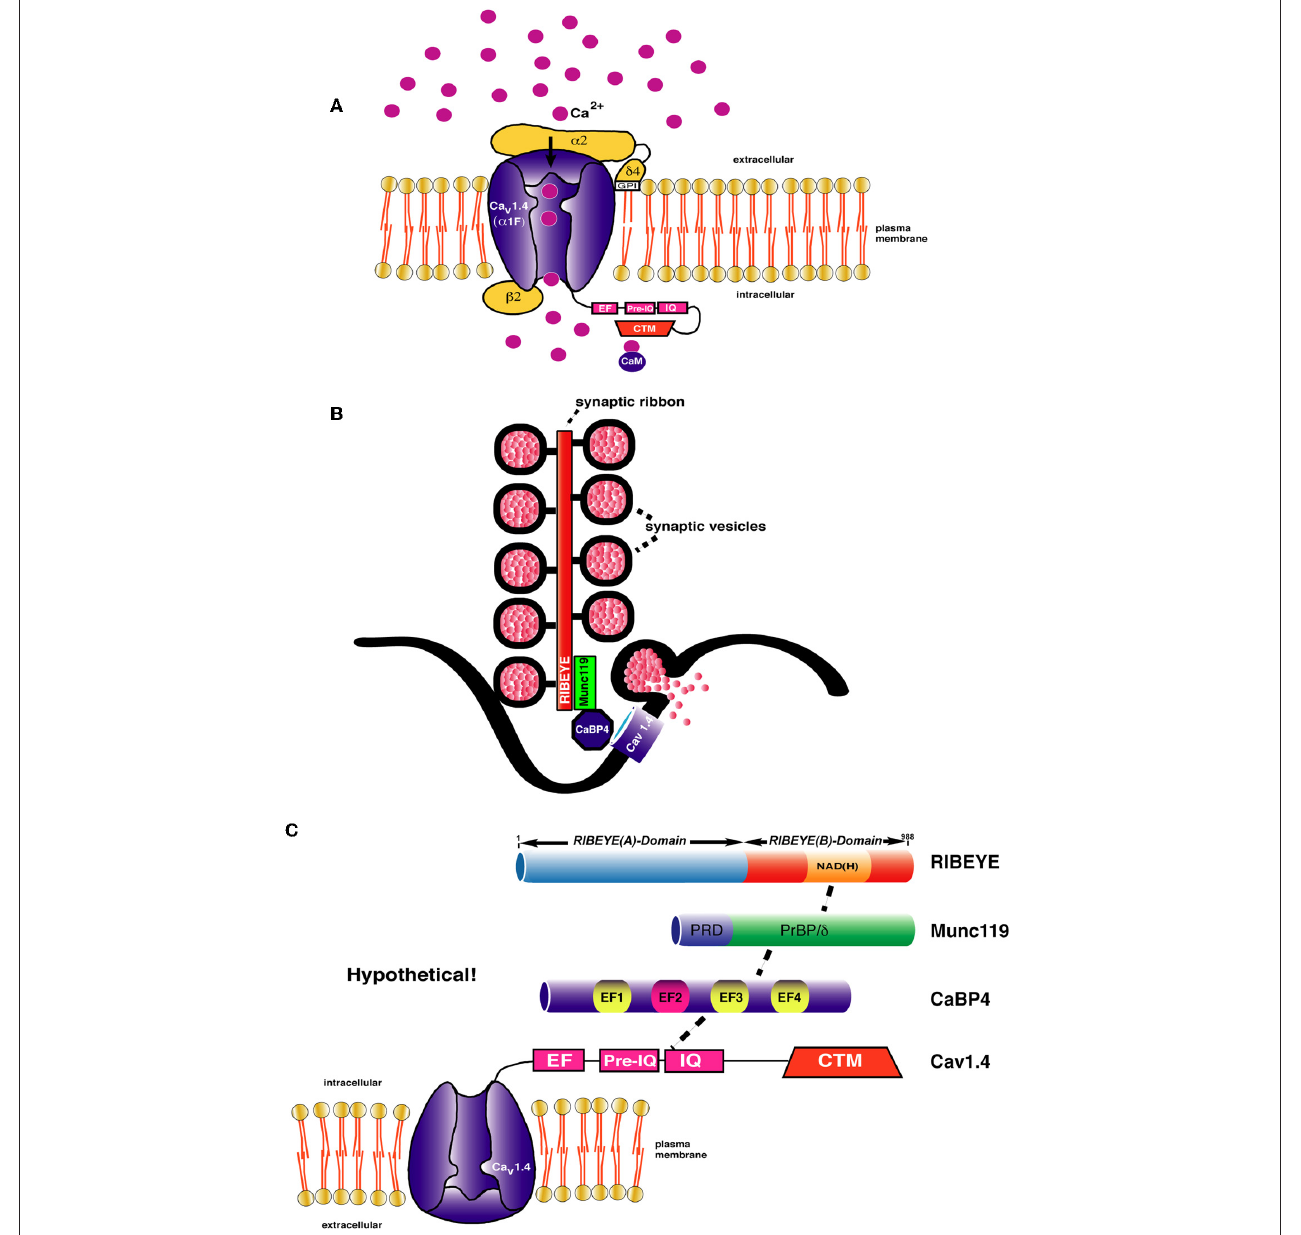
FIGURE 2 | (A) Schematic representation of L-type Ca 2 + -channel composition of rod photoreceptor synapses [drawn modified based on Lacinova (2005)]. The channels are immobilized at the active zone close to the base of the synaptic ribbon. The α 1F-subunit is considered the pore-forming subunit that supports voltage-dependent entry of Ca 2 + . Ca 2 + ions are depicted as pink spheres. The cytoplasmic C-terminus of Ca V 1.4 α 1-subunit contains an EF-hand, Pre-IQ-, and IQ-domain. In other Ca V 1 channels, e.g., Ca V 1.2, these carboxyterminal domains mediate Ca 2 + -dependent inactivation [for review, see Striessnig et al. (2010)]. In Ca V 1.4, CDI is prevented by the additional CTM region that forms an intramolecular interaction with the above mentioned domains [Singh et al. (2006); Wahl-Schott et al. (2006)]. The β 2-subunit interacts with the α 1-subunit at the cytoplasmic loop connecting domain I with domain II [Catterall (2011)]. The alpha2-delta4 ( α 2 δ 4)-subunit, linked to each other with disulfide-bridges (not shown), complements the channel composition [Wycisk et al. (2006); Mercer